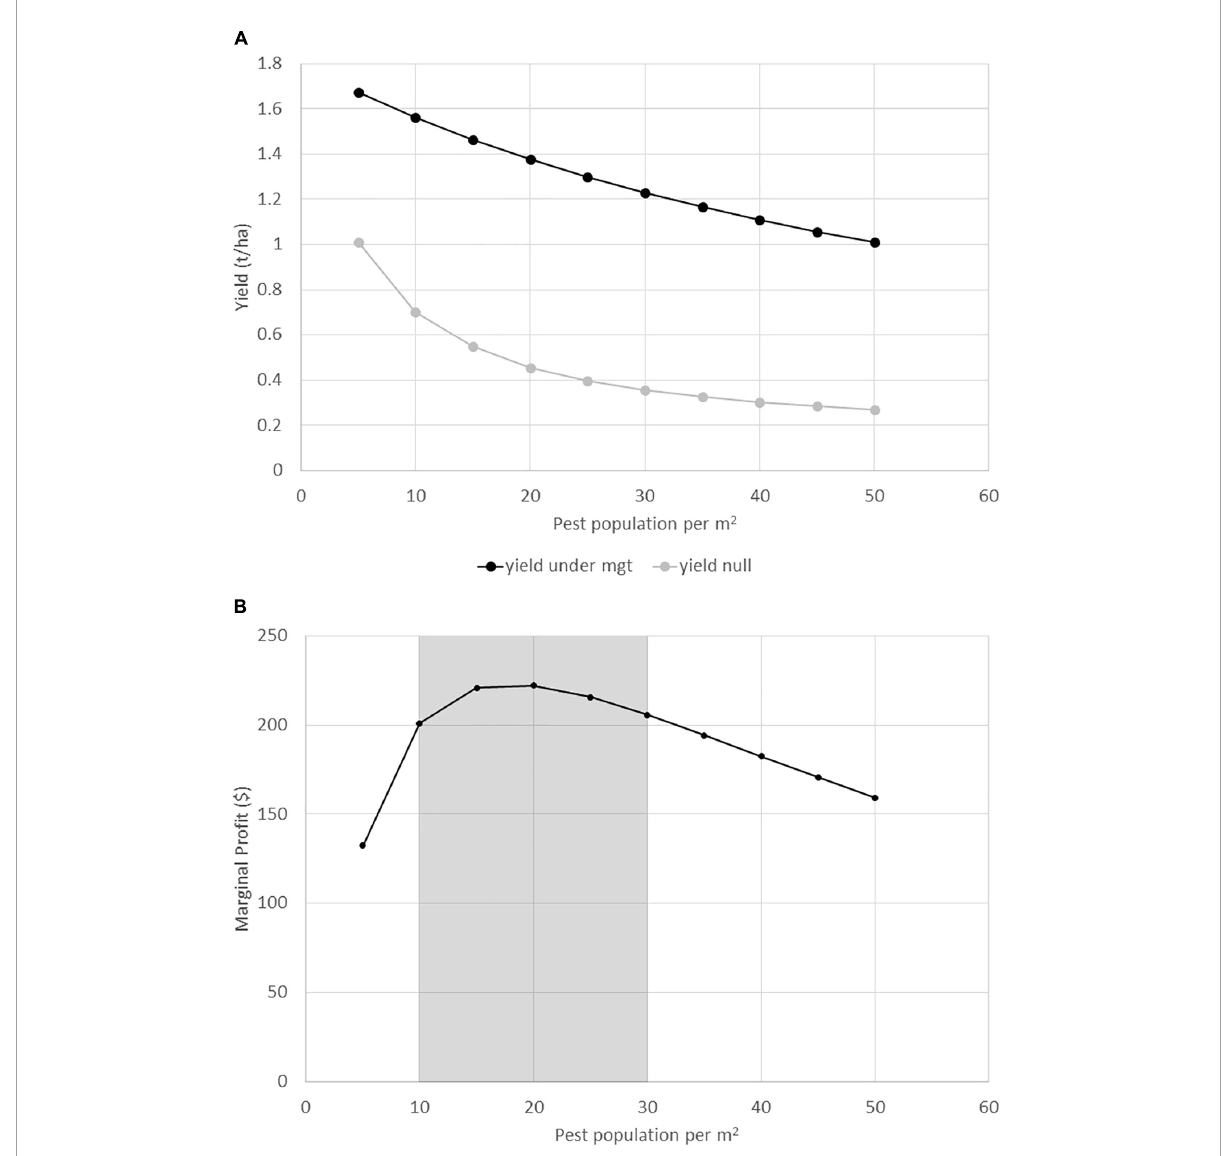
FIGURE4 Comparison of yield between pesticide management and non-management scenarios (A) and the marginal profit from management (B) under increasing pest pressure. Gray shading indicates the zone of optimal profit